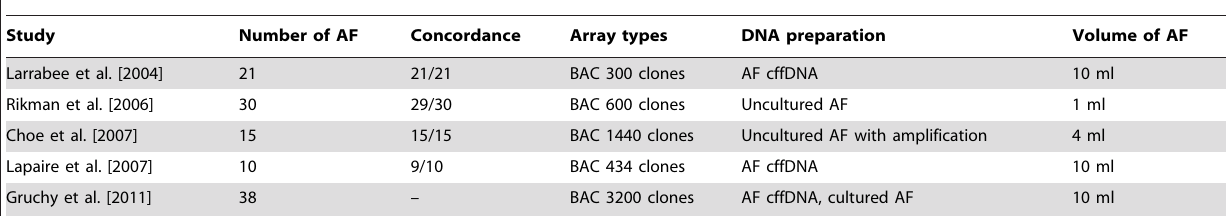
Table 6. Retrospective study of amniotic fluid (AF) by array-CGH.